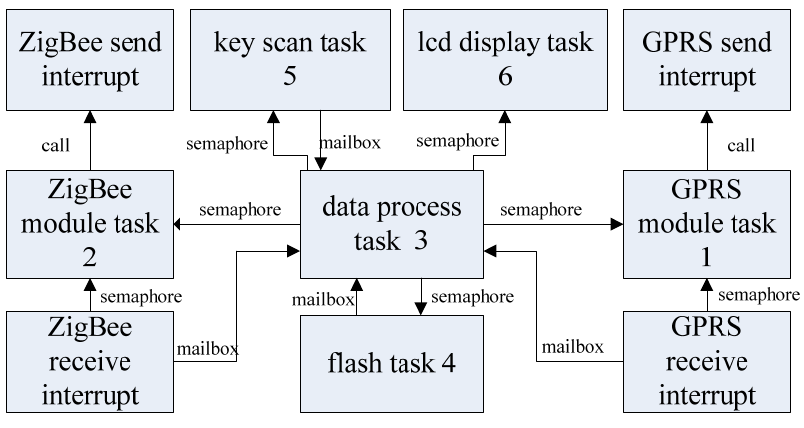
Figure 17. The communication diagram of each